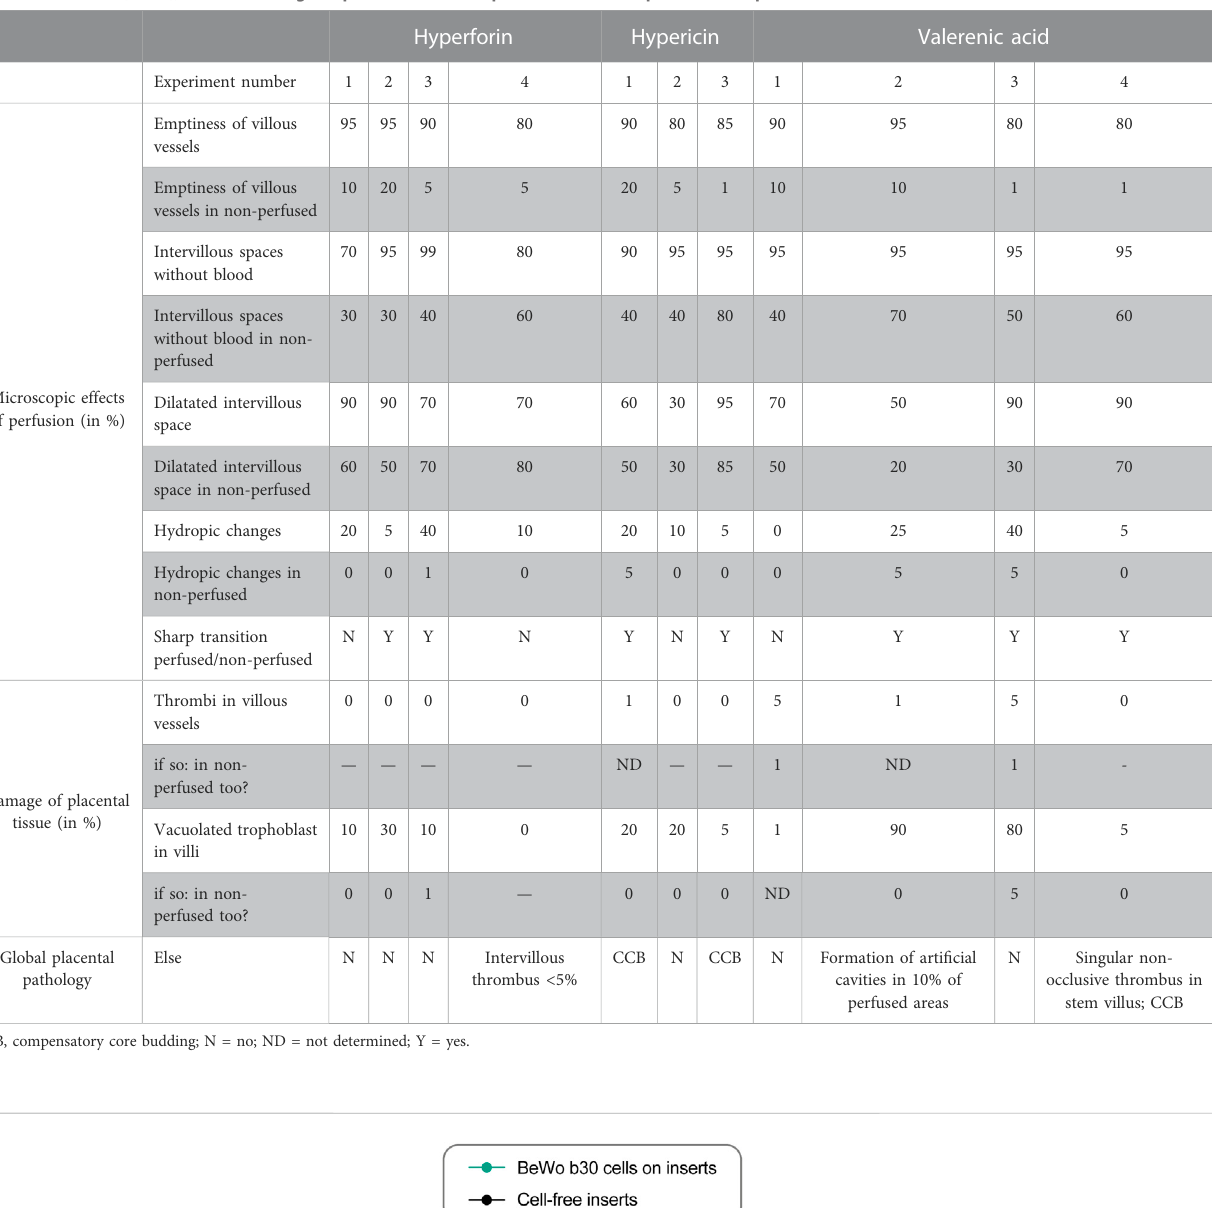
TABLE 3 Detailed histopathological evaluation assessing the microscopic effects of human ex vivo placental perfusions with hyperforin (n = 4), hypericin (n = 3) and valerenic acid (n = 4), and the damage of placental tissue in perfused areas compared to non-perfused areas.